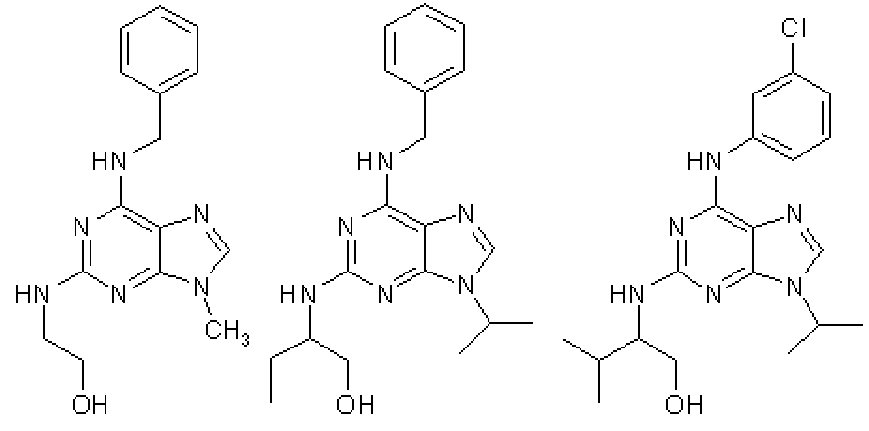
Fig. 1. Chemical structures of olomoucine, roscovitine and purvalanol A (from left to